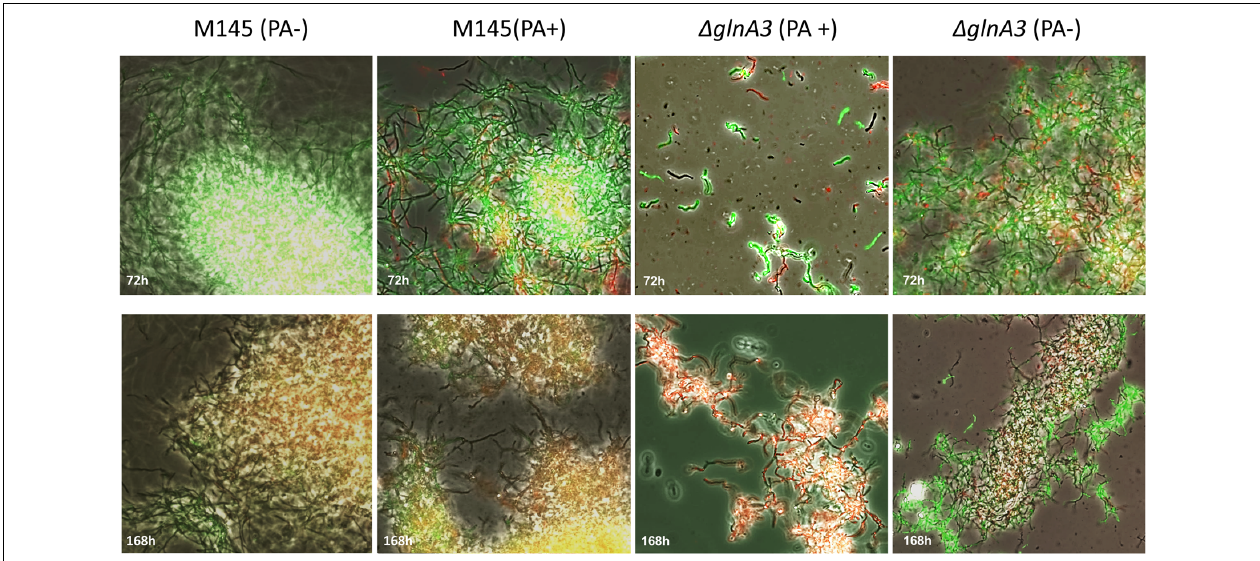
FIGURE 9 | Effect of the glnA3 deletion on cell morphology and its viability in the presence of polyamines. Parental strain S. coelicolor M145 and (cid:49) glnA3 mutant were cultivated in YEME:TSB (1:1) medium with or without polyamines total concentration 100 mM (putrescine, cadaverine, spermidine, and spermine, 25 mM of each). Phase contrast microscopic pictures of parental strain M145 and (cid:49) glnA3 mutant mycelium stained with SYTO9/PI were taken after 72 and 168 h of growth (under 400 × enlargement).